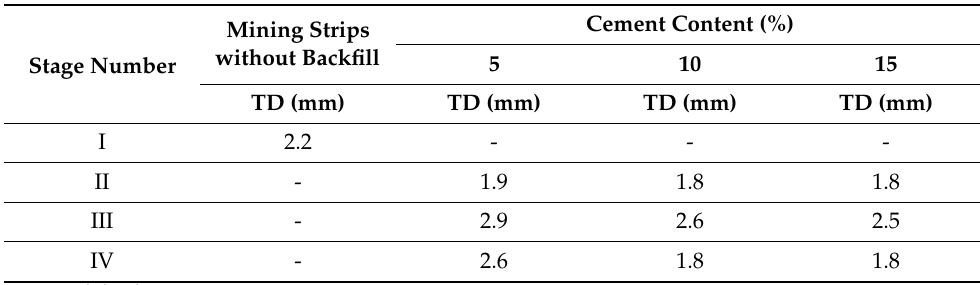
Figure 14. Total displacement for the mining field with 15% cement content in paste backfill: ( a ) second stage; ( b ) third stage; ( c ) fourth stage. Table 3. Summary of the results of the 3D numerical